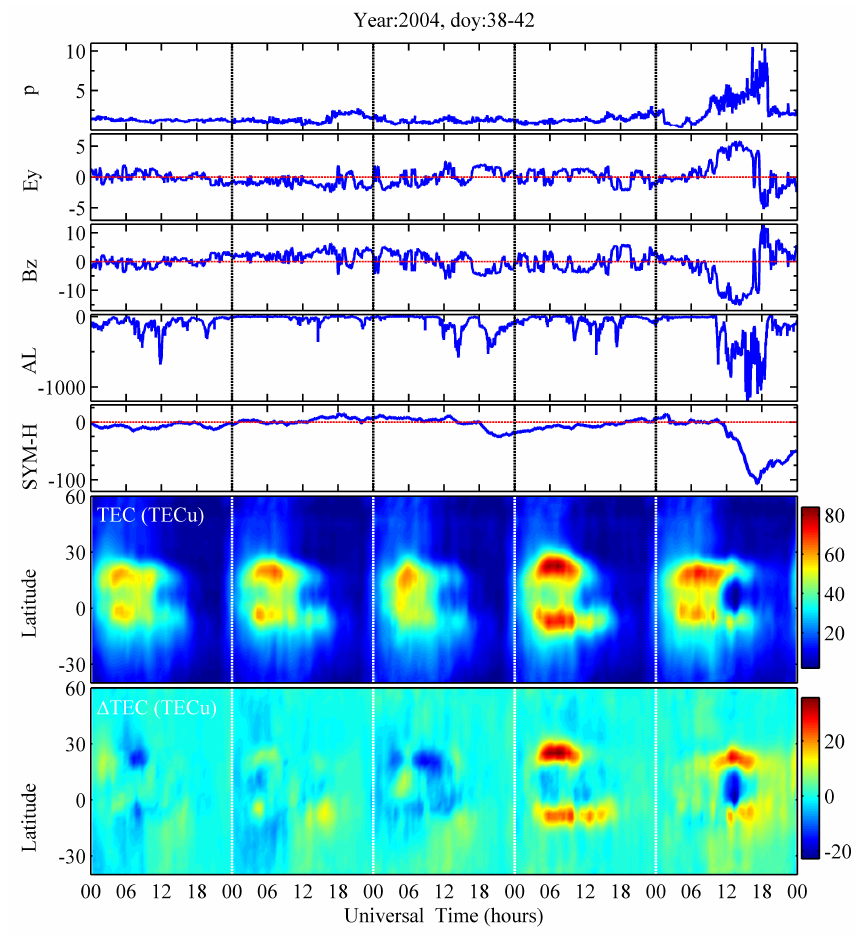
Fig. 1. Solar wind pressure ( p ), IEF E y , and IMF B z measured by the ACE satellite, AL and SYM-H indices, and total electron content (TEC) measured along 120 ◦ E longitude and the deviations ( 1 TEC) from the median TEC values on 7–11 February (days 38–42) 2004. The median values are evaluated from the 31-day observations centered on 10 February, 2004. The ionospheric TEC were enhanced at low latitudes in both hemispheres on 10 February